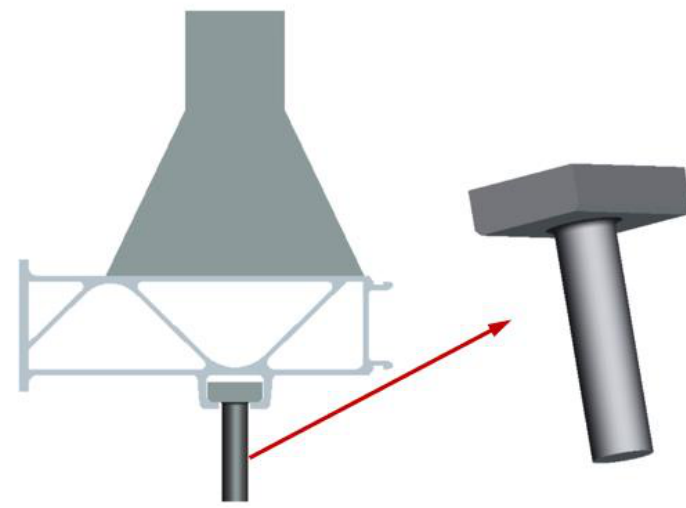
Figure 4. Suspension structure and connecting bolt.